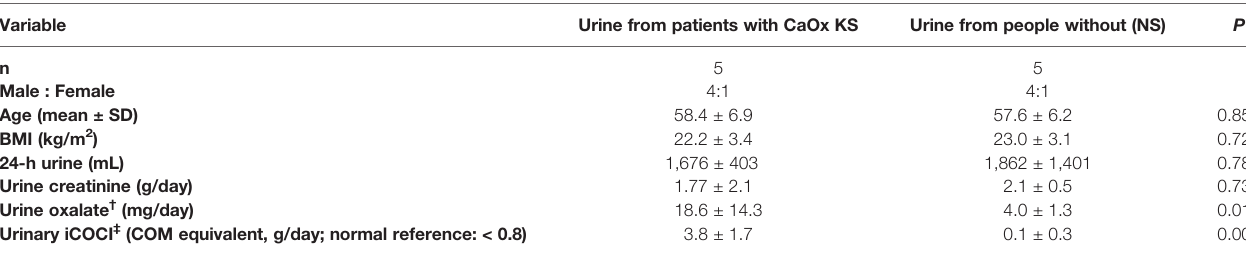
TABLE 1 | The characteristics of donors of 24-h urine samples used in the study. Variable Urine from patients with CaOx KS Urine from people without